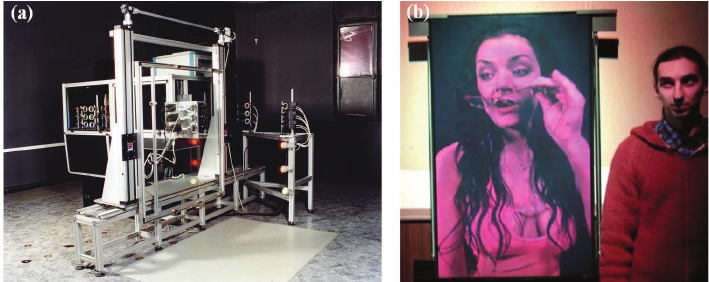
Figure 10. The first RGB pulsed laser holographic printer made by Geola in 2001 ( a ) and the printed hologram ( b ). (Reprinted with permission from ref [47],